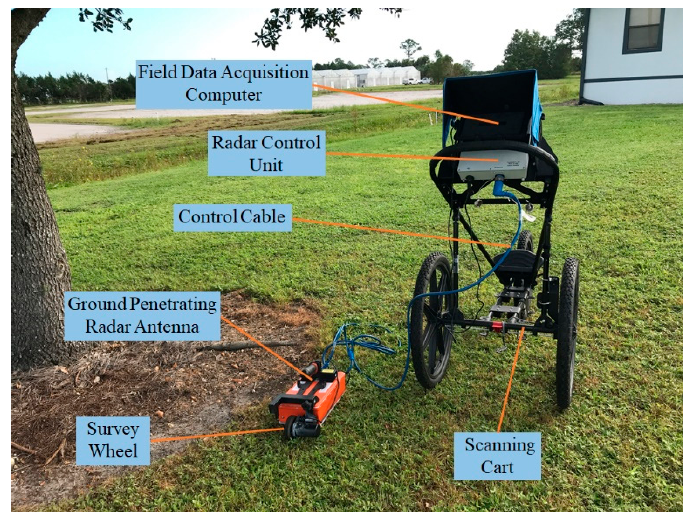
Figure 1. A ground-penetrating radar (GPR) mounted to a scanning cart.